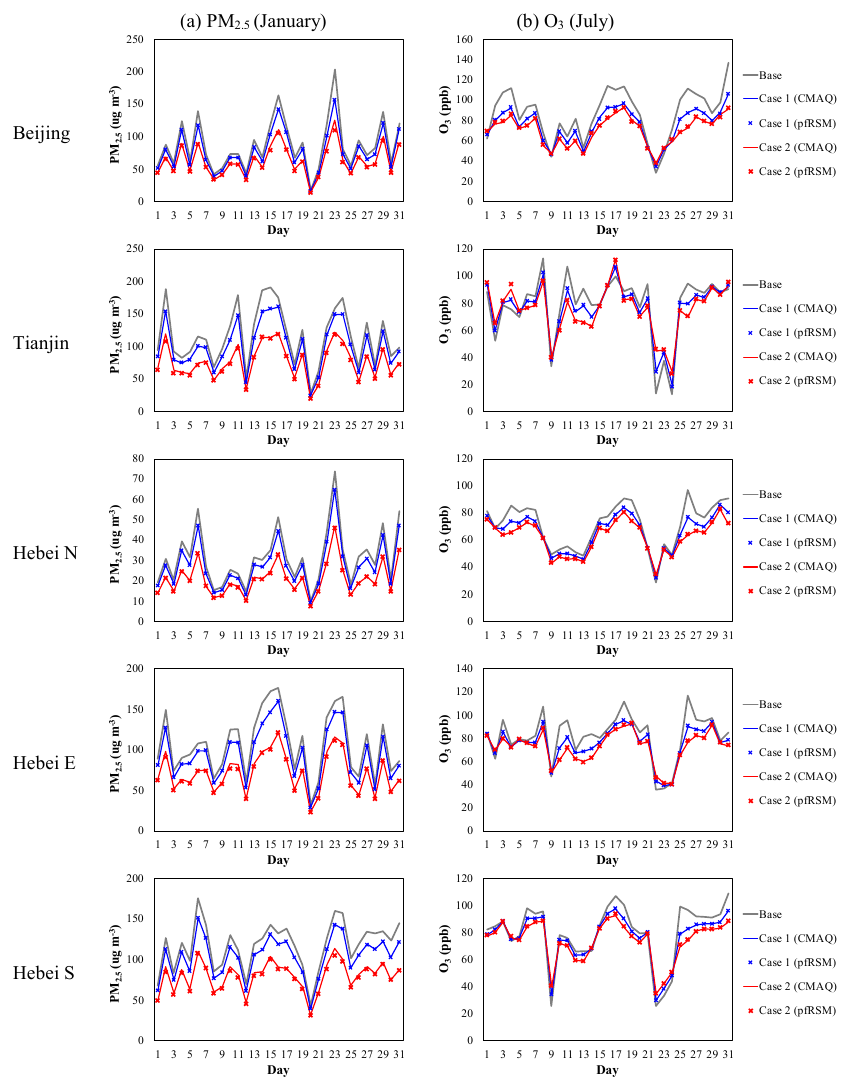
Figure 9. Daily series of CMAQ-simulated and pf-RSM-predicted daily averaged PM 2 . 5 in January and daily 1h maxima O 3 in July 2014 in the baseline and two control scenarios ( E NO and − 76, − 79, − 81, − 83, and − 73%,